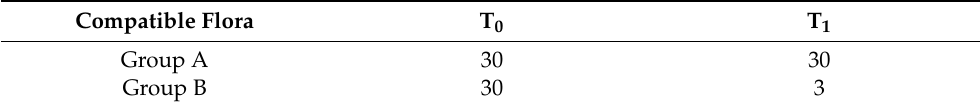
Table 1. Patients with non-pathogenic flora at first (T 0 ) and second (T 1 ) evaluation. Compatible Flora T 0 T 1 Group A 30 30 Group B 30 3 Patients at the time of recruitment, already using the complete home protocol, had a plaque index of less than 30% (Table 2). At the time of re-evaluation, group B showed a